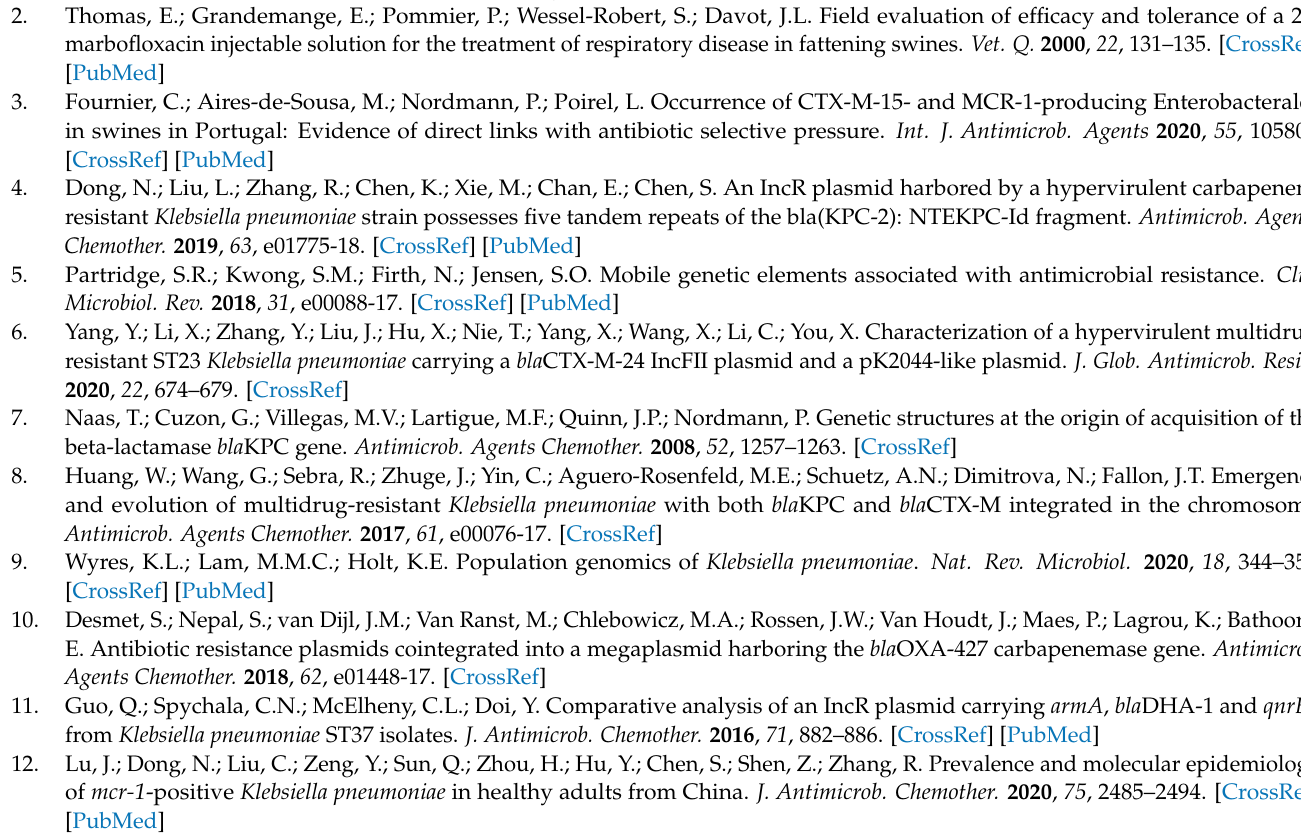
K. pneumoniae ZYST1; Figure S2: Circular representation of plasmid pYhe2002; Figure S3: Linear illustration of the MDR region of plasmid pYhe2001 and comparative analysis of this region in pOZ181 from Citrobactere freundii B38; Table S1: Antimicrobial resistance profile of K. pneumoniae 200; Table S2: Characteristics of K. pneumonia strain 200; Table S3: Compared plasmid pYhe2002 with the plasmid records contained in PLSDB; Table S4: Compared plasmid pYhe2001 with the plasmid records contained in